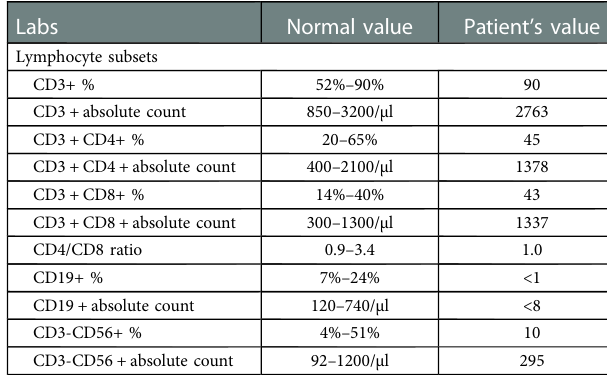
TABLE 1 Lymphocyte subset testing prior to